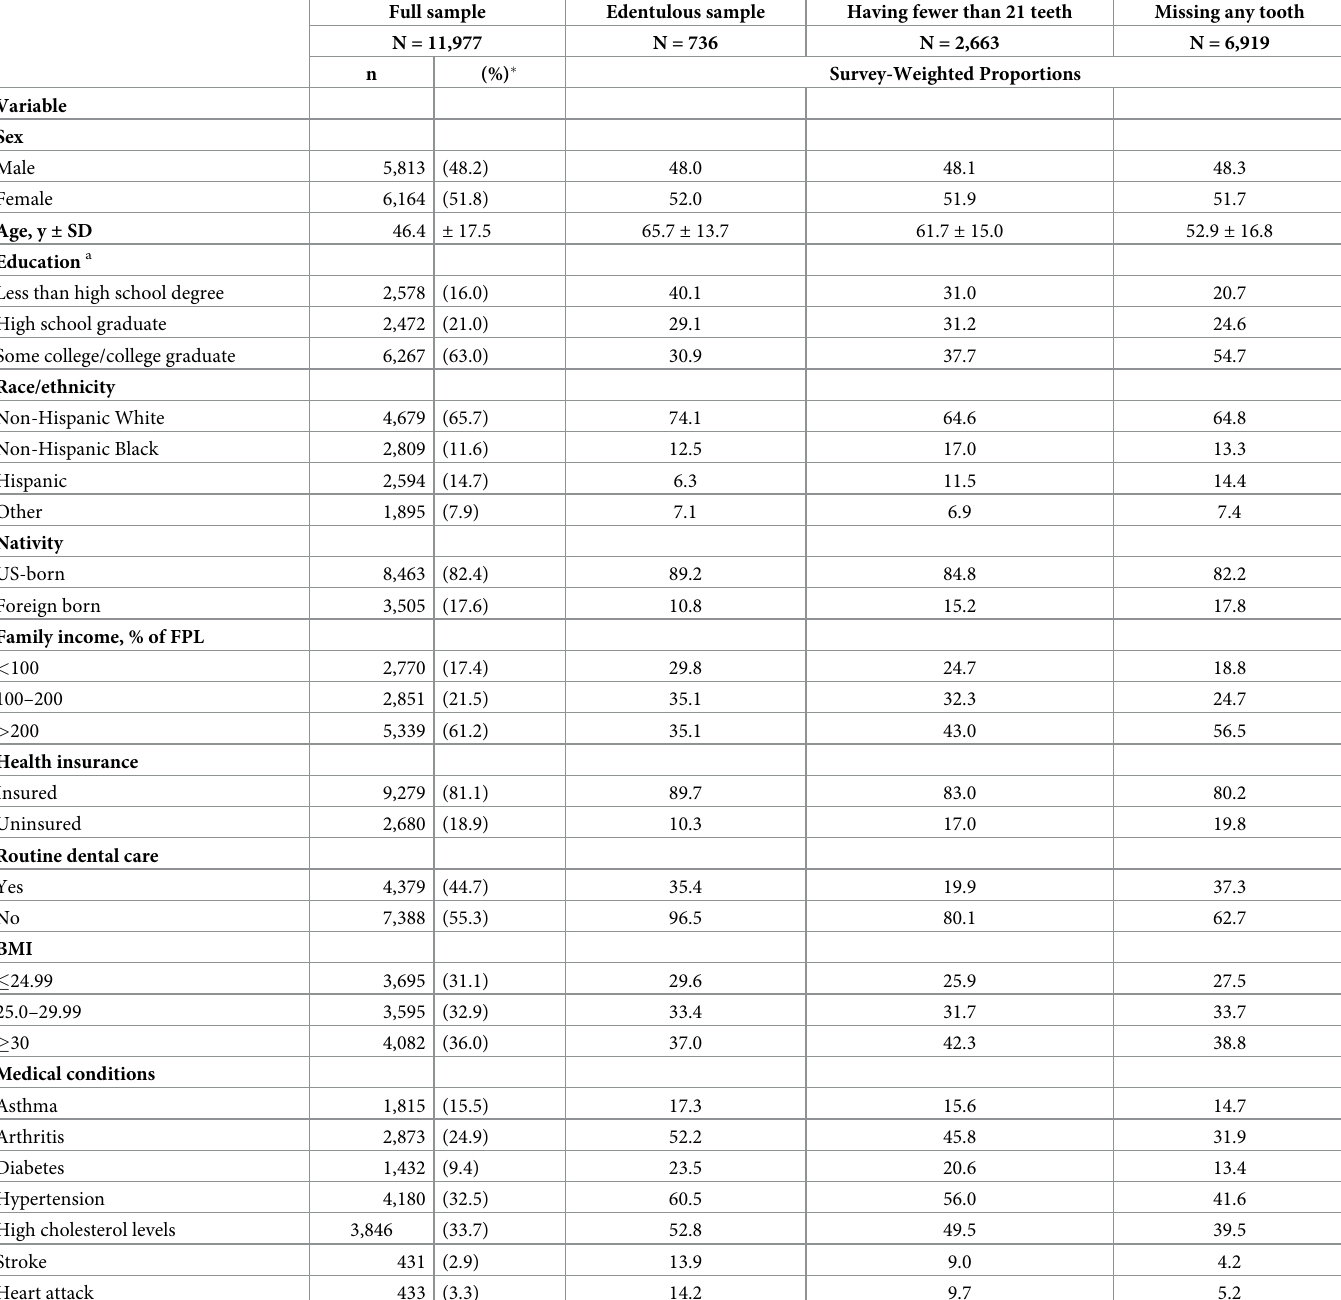
Table 1. Demographic characteristics of the study sample: National Health and Nutrition Examination Survey